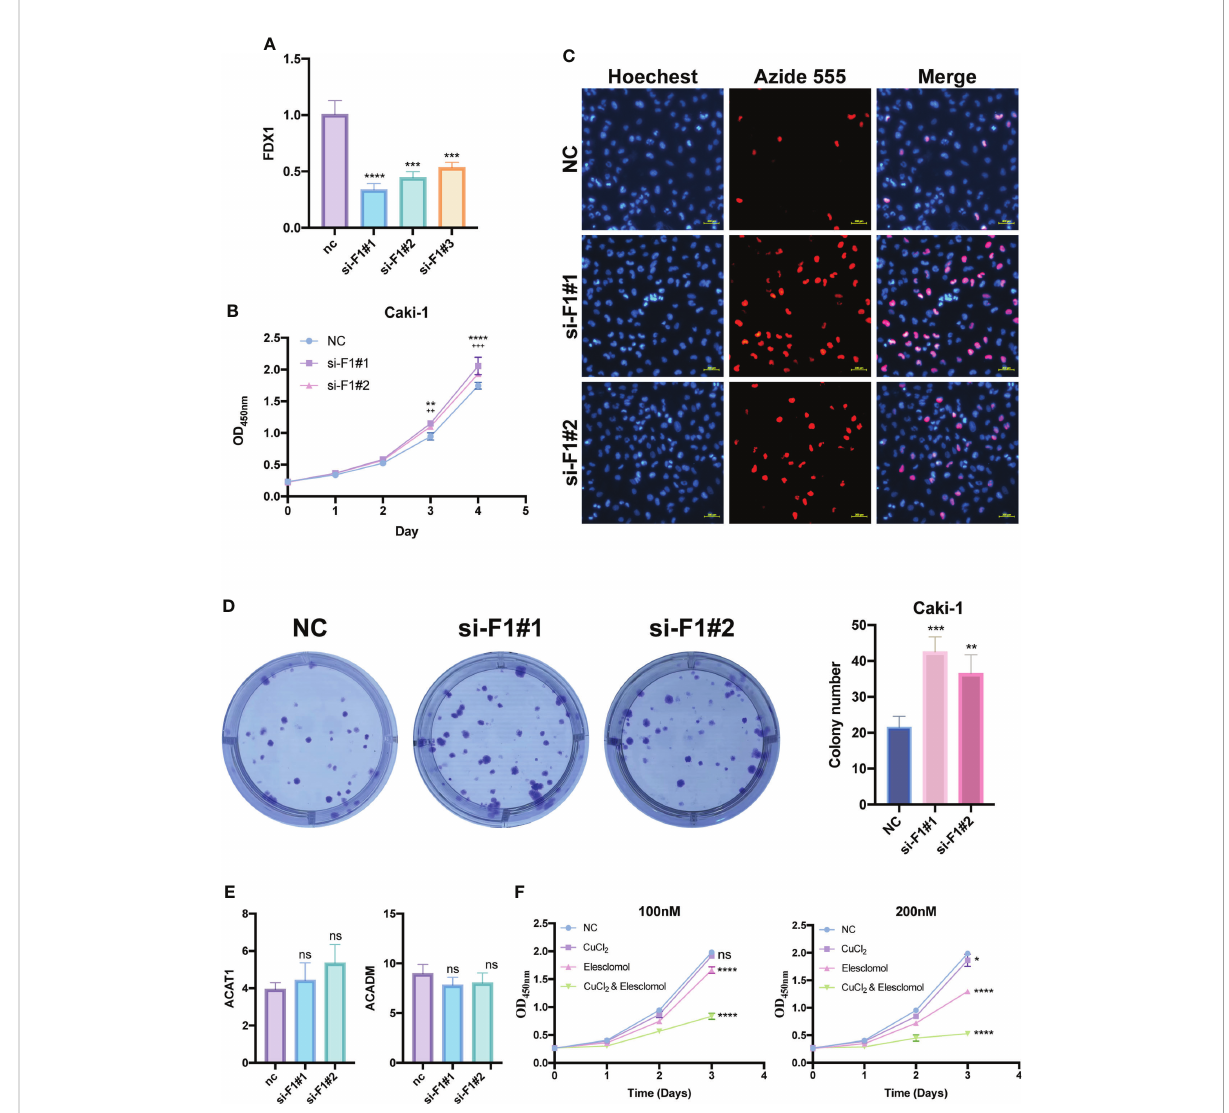
FIGURE 11 Proliferation functional validation of FDX1 and validation of cuproptosis in KIRC cells. (A) Silencing ef fi ciency of FDX1 by qRT-PCR. CCK8 assay (B) , EDU assay (C) and Colony formation assay (D) show the effect of FDX1 knockdown on the proliferation of Caki-1 cells. * is for si-F1#1, + is for si-F1#2. (E) Changes in ACADM and ACAT1 mRNA expression levels after knockdown of FDX1 by qRT-PCR. (F) The effects of elesclomol and